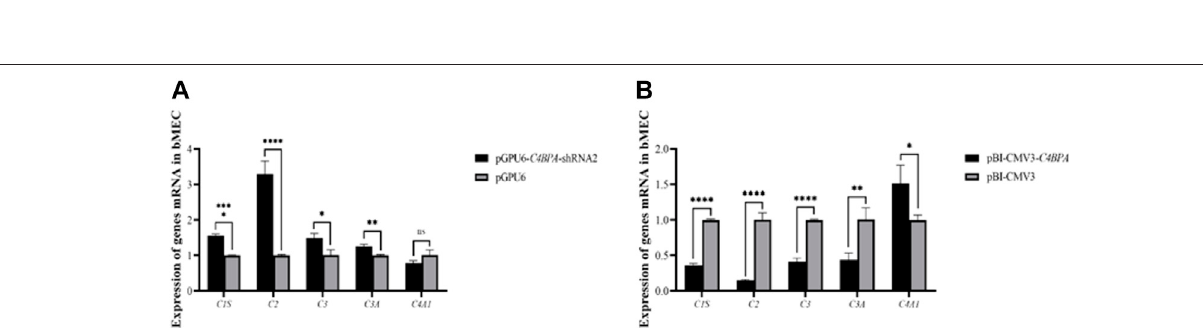
Frontiers in Genetics |